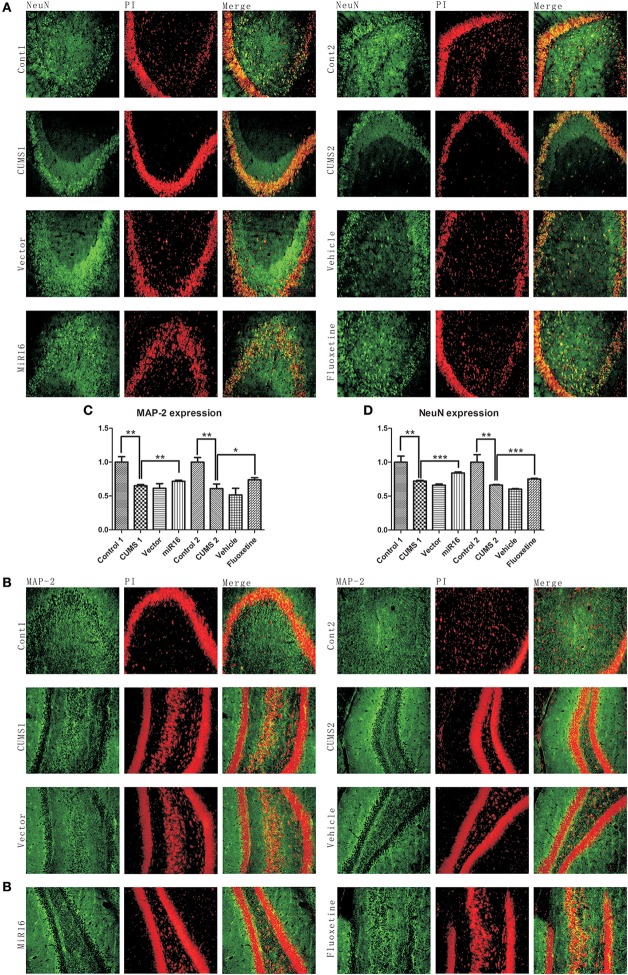
Immunofluorescence staining of NeuN and MAP-2 expression represent lower expressions of neuronal cells after CUMS. Expression levels of NeuN and MAP-2 are used to track neuron or dendrite formation. (A) Representative images of NeuN staining from each group. (B) Histogram of NeuN staining, a significant decrease presented in CUMS groups compared to the Control. Values are presented as means ± SEMs. *P < 0.05; **P < 0.001; ***P < 0.0001. (C) representative images of MAP-2 staining from each group. (D) Histogram from MAP-2 staining show similar change tendencies with NeuN expression in the rat hippocampus in each group. Values are presented as means ± SEMs. *P < 0.05; **P < 0.001; ***P < 0.0001.